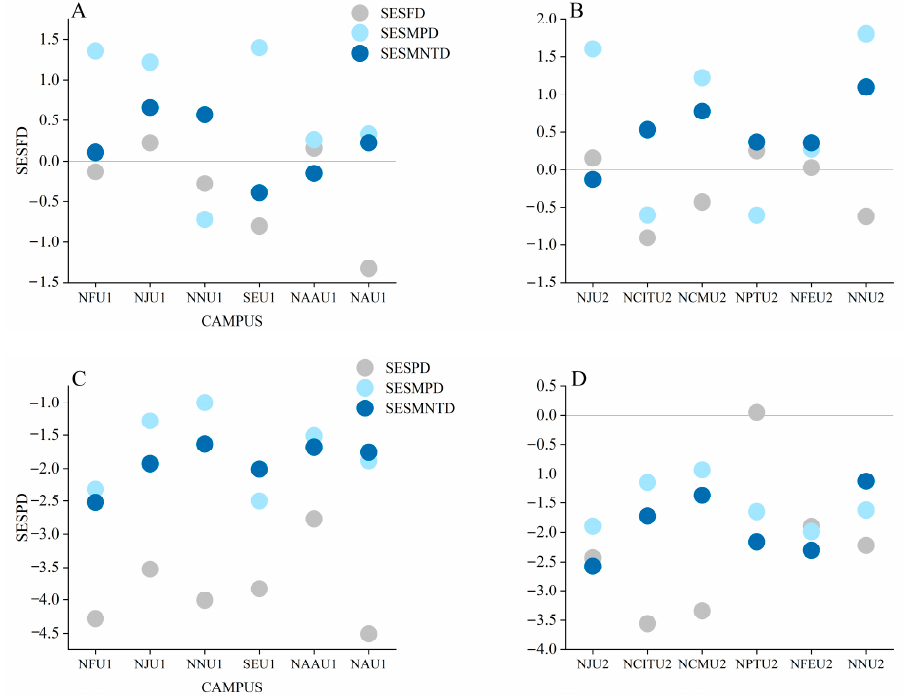
Figure 2. Standardized functional and phylogenetic diversities at 12 university campuses. ( A , C ), bird diversities at the campuses located in downtown areas; ( B , D ), bird diversities at the campuses in the newly developed areas. SESFD: standardized values of functional diversity; SESPD: standardized values of phylogenetic diversity; SESMPD in ( A , B ): standardized values of the mean pairwise distance of functional diversity; SESMNTD in ( A , B ): standardized values of the mean pairwise distance of functional diversity; SESMPD in ( C , D ): standardized values of the mean nearest taxon distance of phylogenetic diversity; SESMNTD in ( C , D ): standardized values of the mean pairwise distance of phylogenetic diversity. For abbreviations of each campus name, see Figure 1.